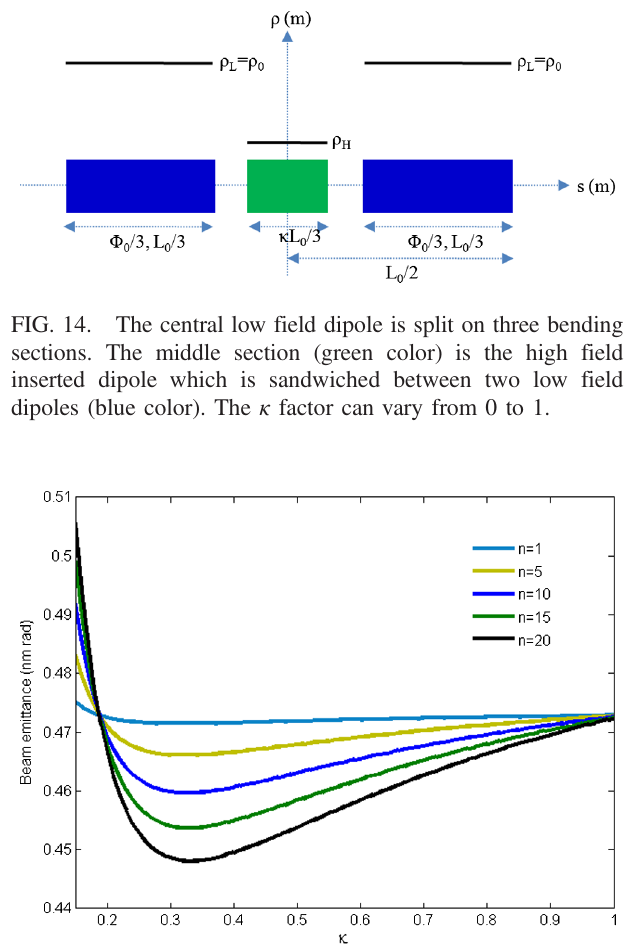
FIG. 15. Beam emittance as a function of κ factor for the different number of the inserted high field